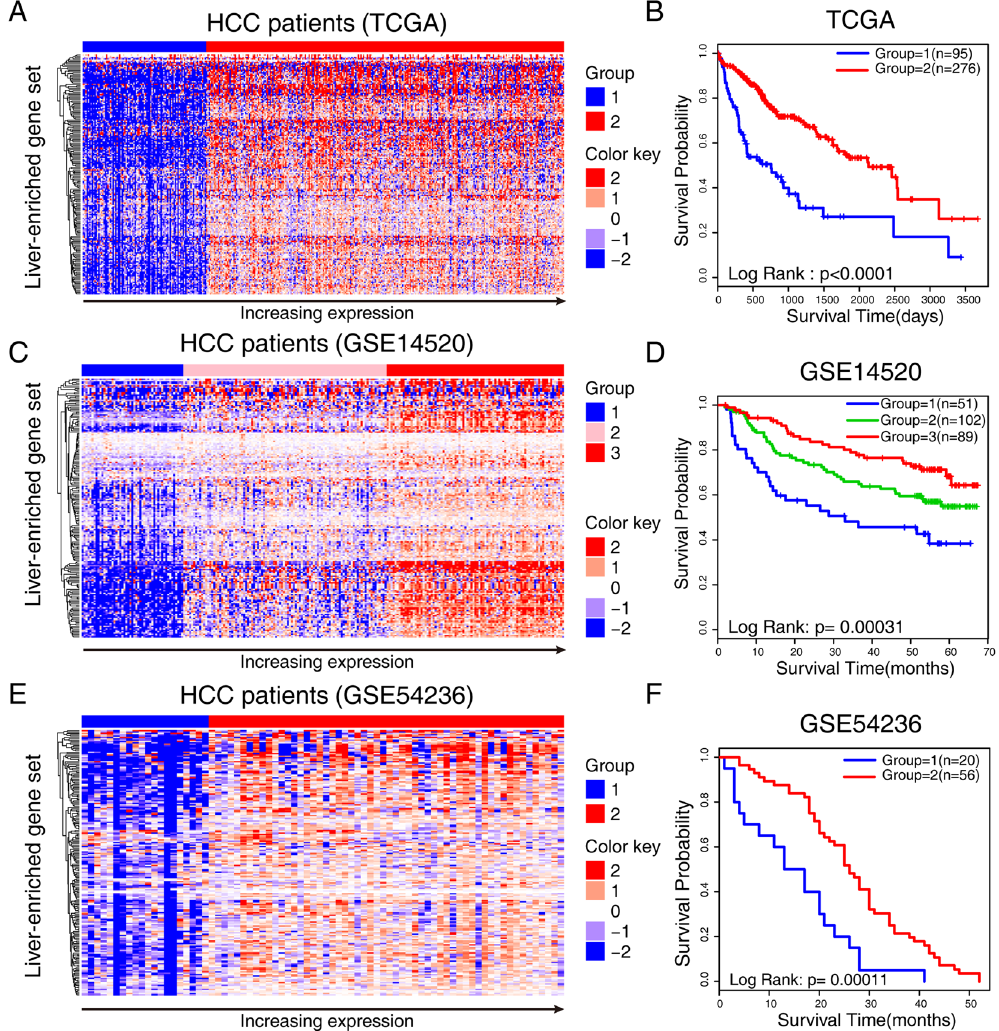
Figure 6. Liver-enriched gene set is associated with the prognosis of patients with HCC. Heatmap shows the unsupervised consensus clustering result of the liver-enriched genes in the ( A ) TCGA, ( C ) GSE14520, and ( E ) GSE54236. The expression level of liver-enriched genes increased from blue to red color. ( B ) Survival analysis of the groups generated from consensus clustering with the ( B ) TCGA, ( D ) GSE14520, and ( F ) GSE54236